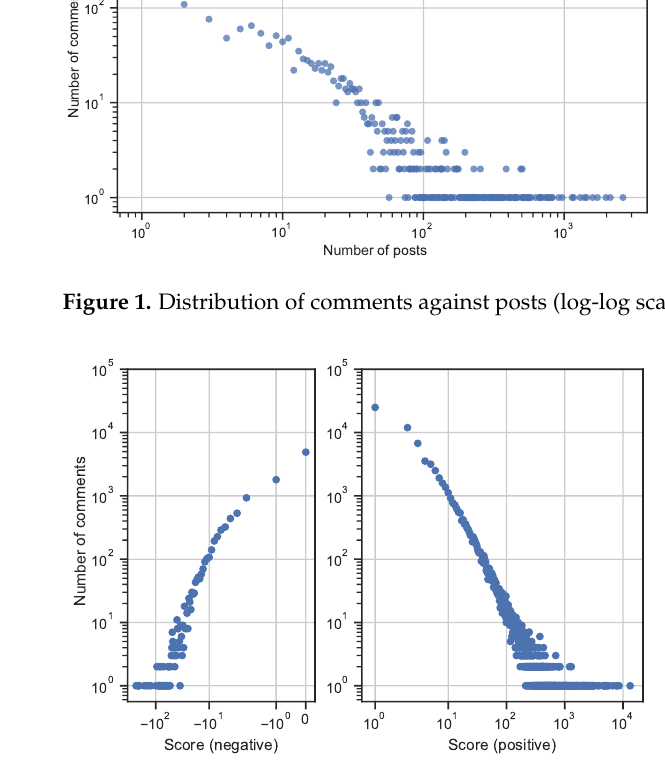
Figure 2. Distribution of comments against score (log-log scale). Table 2. Values of α and δ of the power law distributions for the considered dataset— ∗ These values were computed considering the absolute values of